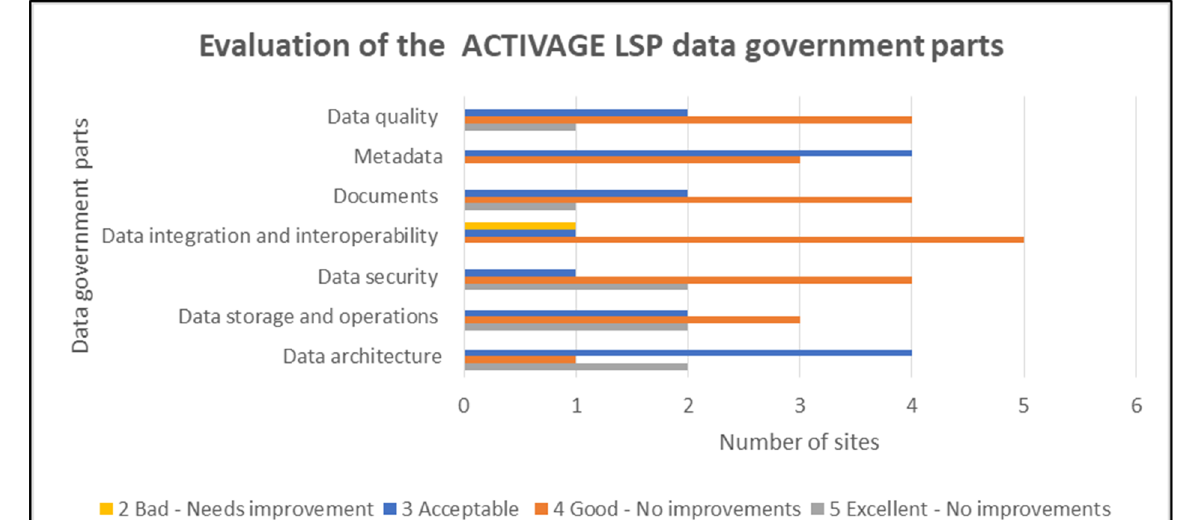
Figure 8. Evaluation of the ACTIVAGE LSP data government parts.